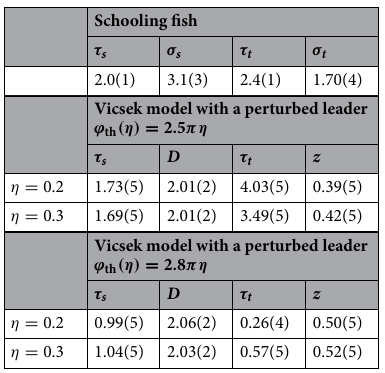
Table 1. Summary of scaling exponents for the avalanche size and duration distributions obtained from observations of a real fish school and from the Vicsek model with a perturbed